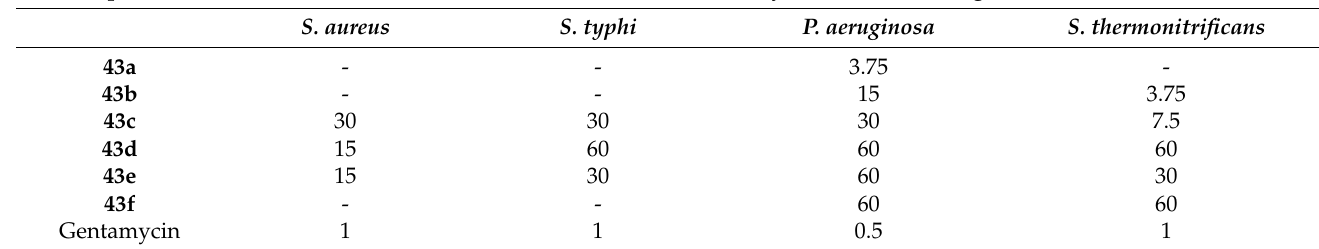
(Table 2) [34]. The anti- Aspergillus activity was evaluated by disc diffusion assay